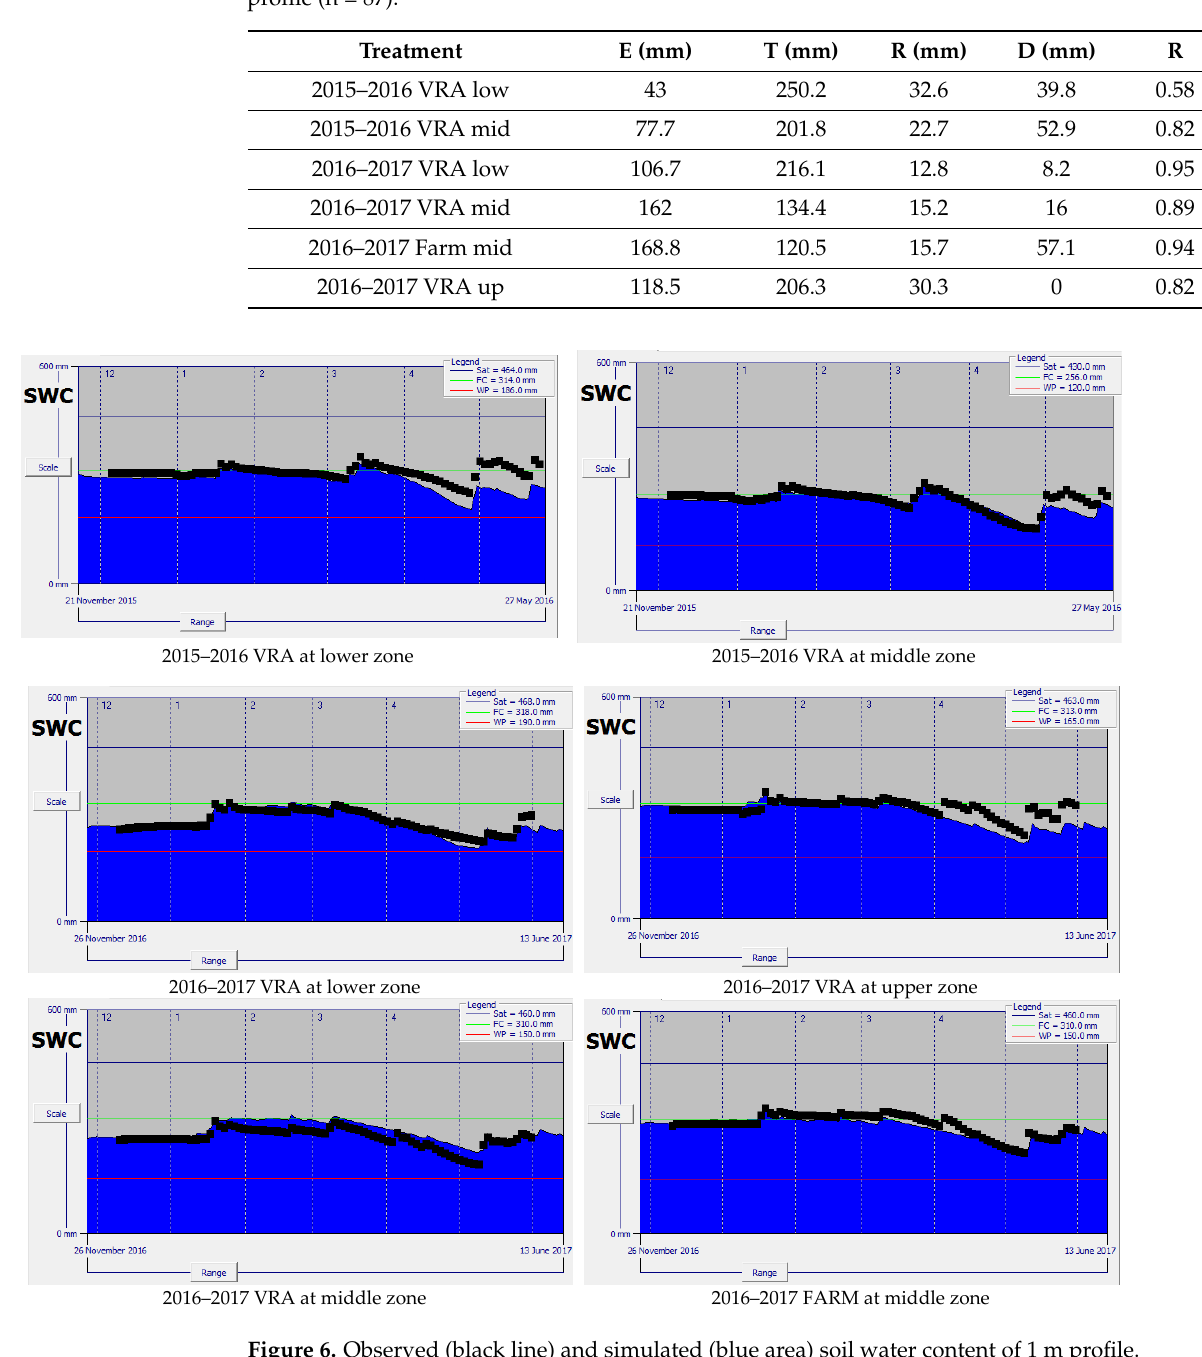
Figure 7. Field versus simulated yield for the plots selected for validation. Table 6. Results of calibration simulations (kg/ha) using fertility as adjustment parameter. Average fertility for each zone treatment (Blocks 2 and 3). Lowland